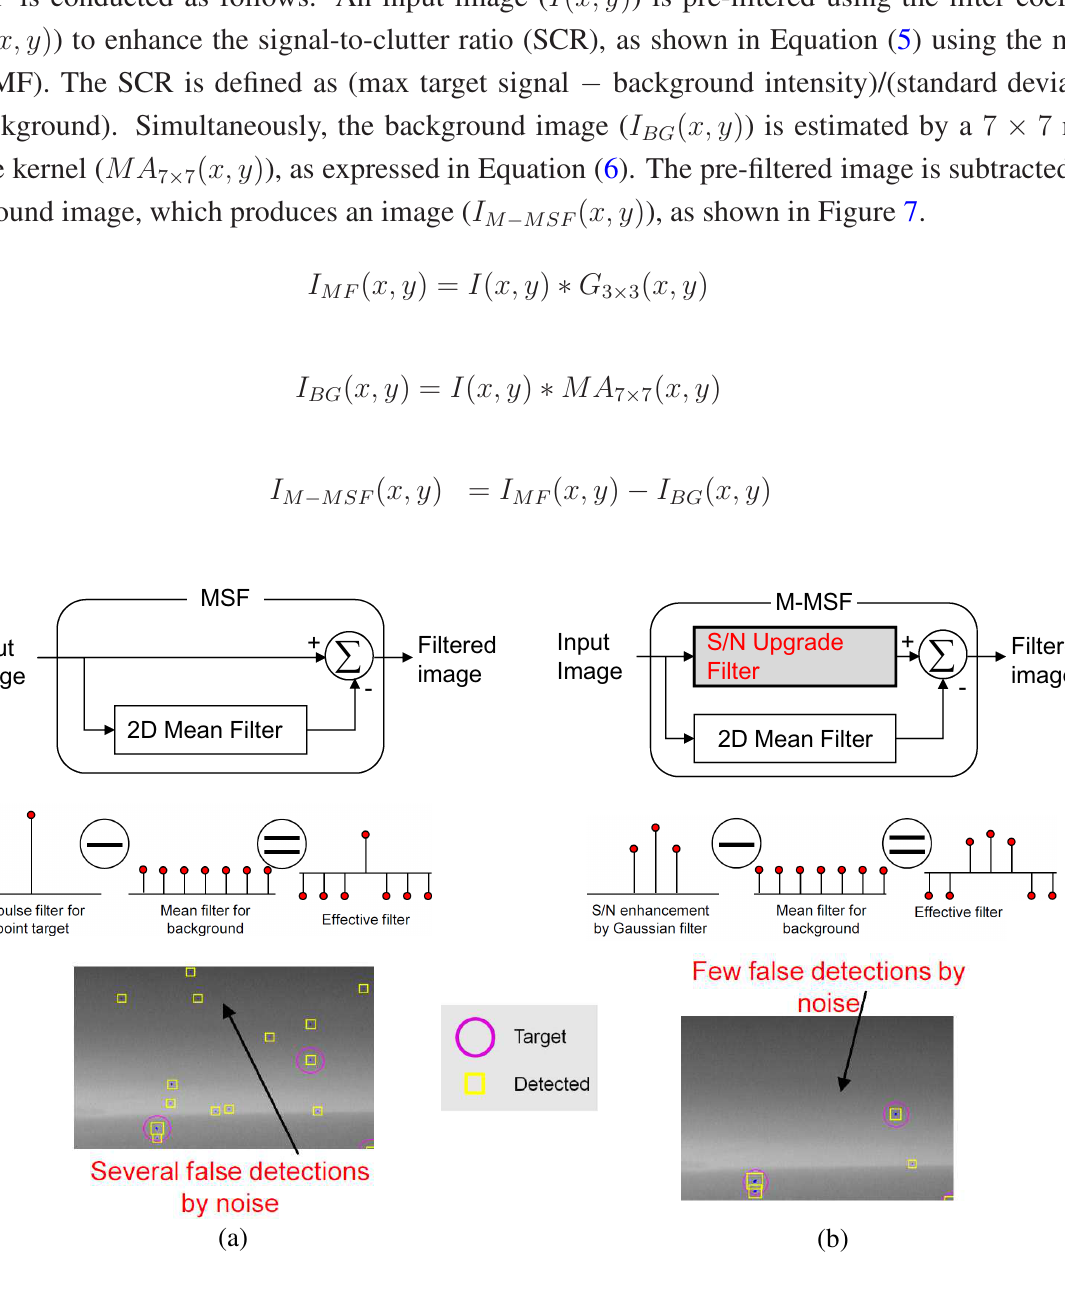
Figure 6. Basic concept of the modified mean subtraction filter (M-MSF): ( a ) previous MSF; ( b ) modified MSF by inserting an S/Nupgrade